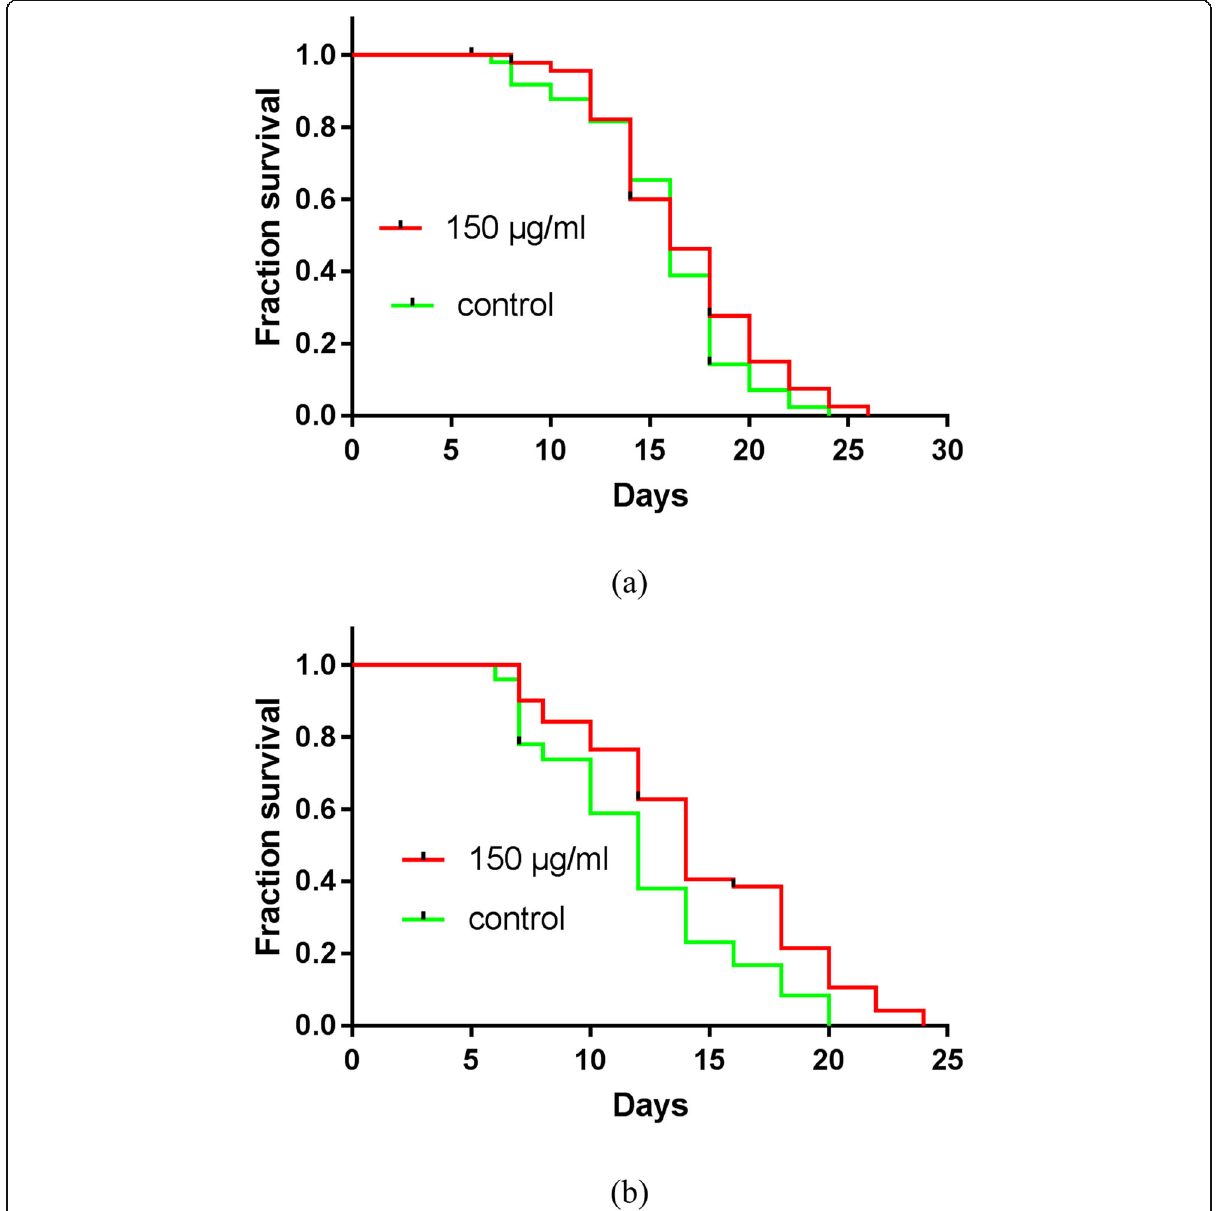
Fig. 1 Effect of JPYW on the lifespan of C. elegans N2 worms under normal conditions. a The worms were treated with JPYW beginning at the larval stage. The curves show the percentages of surviving worms on different days after treatment with a vehicle control (1% DMSO) or 150 μ g/ ml JPYW. JPYW did not significantly prolong the lifespan of wild-type worms, but it caused a positive trend in the number of surviving aged worms ( n = 50). b The aged worms were exposed to JPYW beginning on the 7th day of adulthood. The curves show the percentages of surviving worms on different days after treatment with a vehicle control (1% DMSO) or 150 μ g/ml JPYW. JPYW significantly prolonged the lifespan of aged wild-type worms; n = 50 – 51, P <